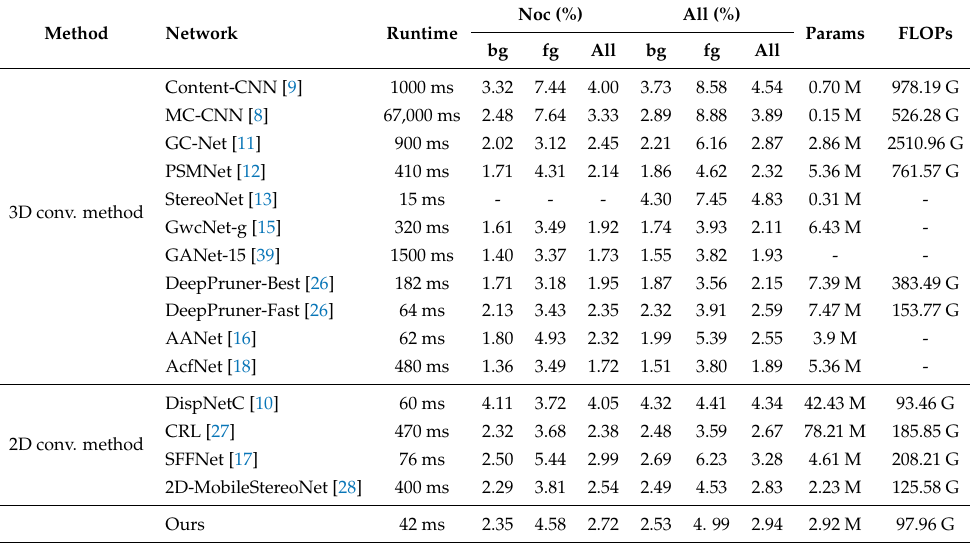
Table 3. Quantitative comparison results on the KITTI 2015 test